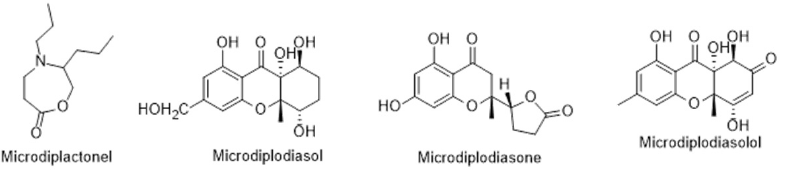
Figure 10. Metabolites isolated from endophytic Microdiplodia sp. isolated from L. intricatum .